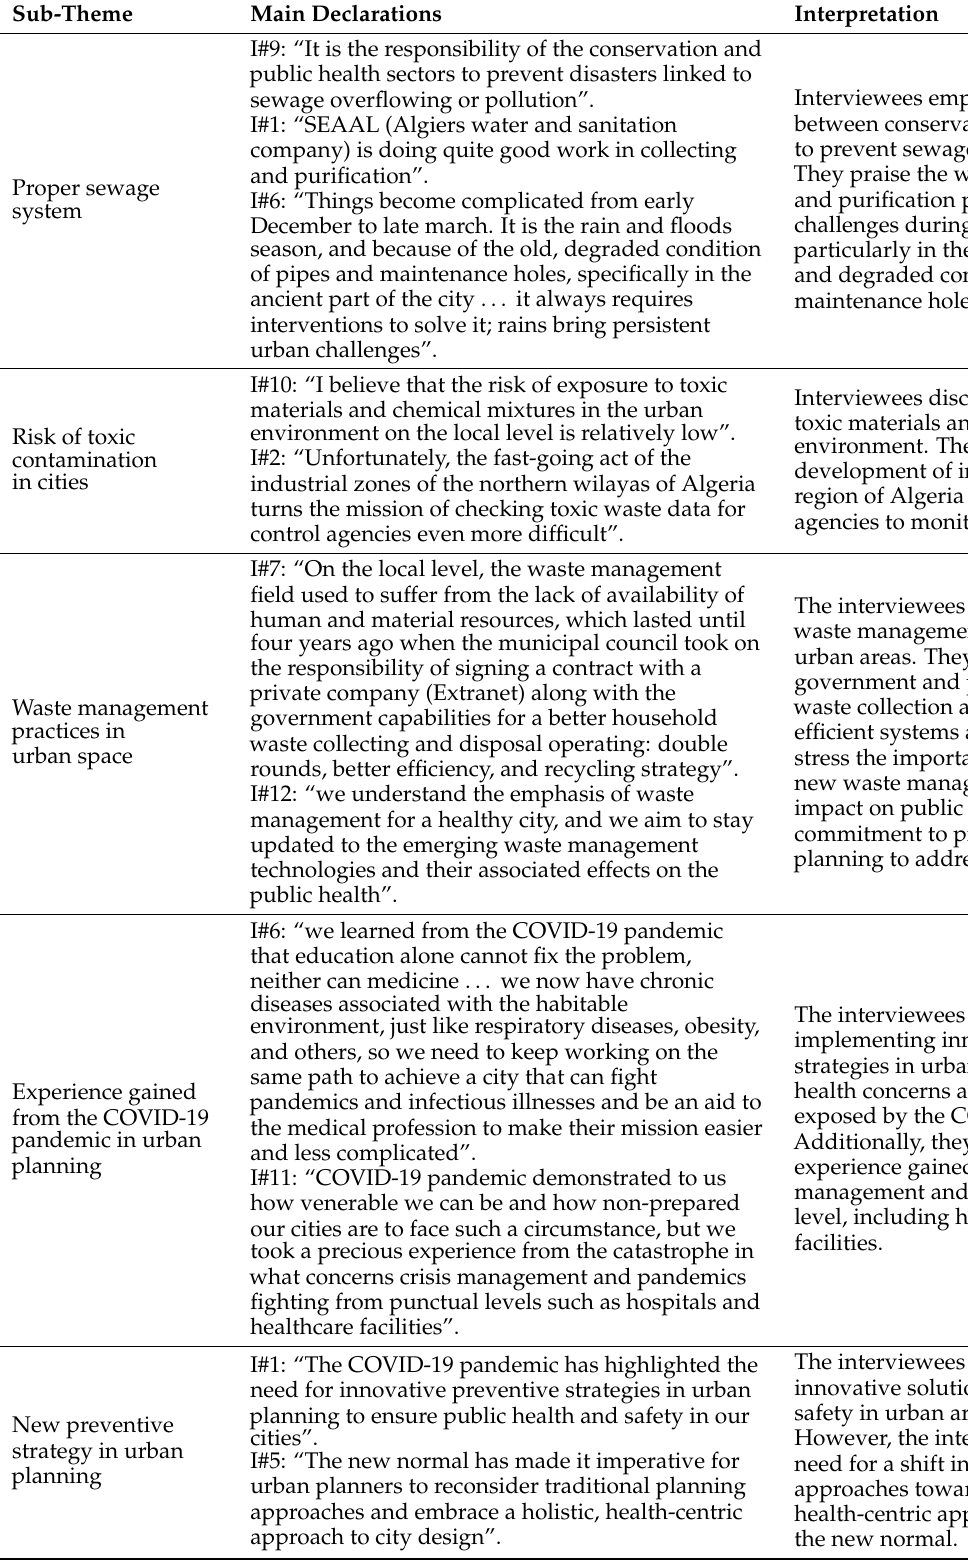
Table 1. Theme 1: sanitary elements affecting public health in urban space—results